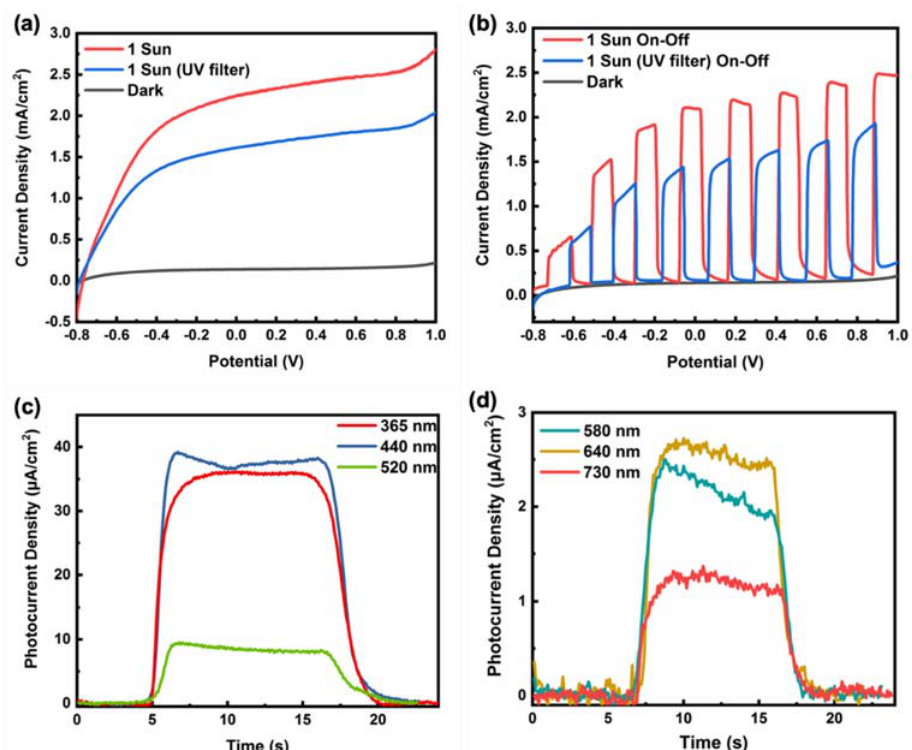
Figure 1. Photocurrent density plots: ( a ) Photocurrent measured by linear sweep voltammetry under AM 1.5G illumination; ( b ) Photocurrent response during light on–off cycles, measured by linear sweep voltammetry under AM 1.5G illumination with and without UV cut-off filter (>420 nm); ( c , d ) Amperometric I-t curves showing photocurrent response under the illumination of near- monochromatic LEDs above at 0.3 V vs. Ag/AgCl.